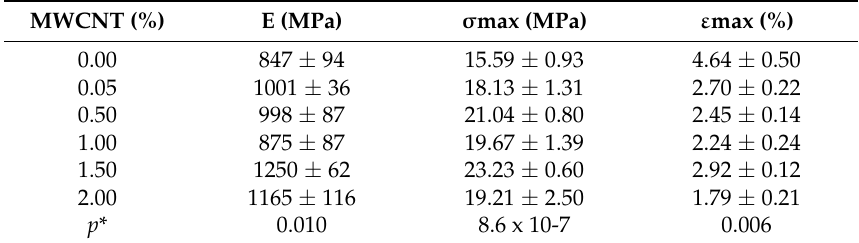
Table 3. Tensile modules (E), tensile strength (  max) and elongation at break (  max) of neat PHBV and nanocomposites.